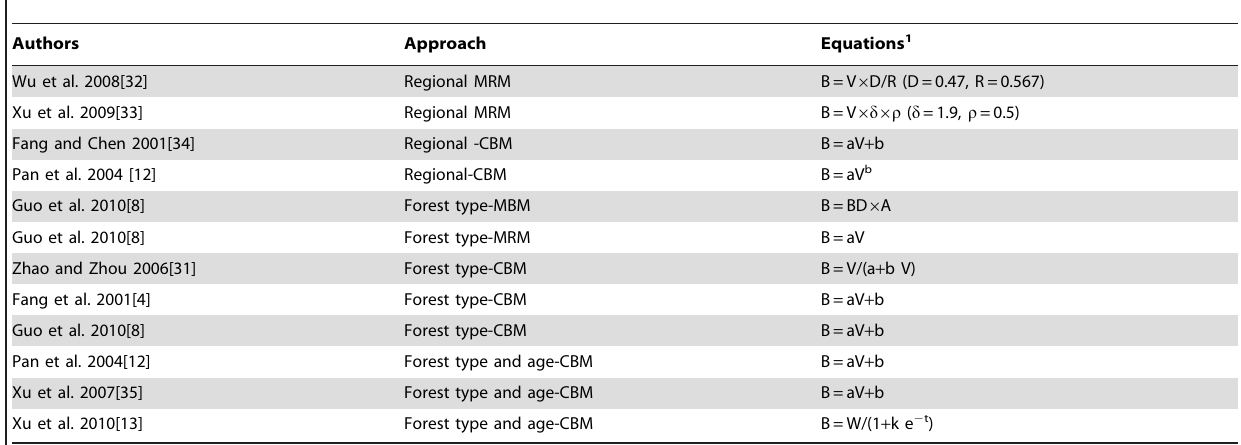
Table 2. Approaches in published studies for estimating forest biomass